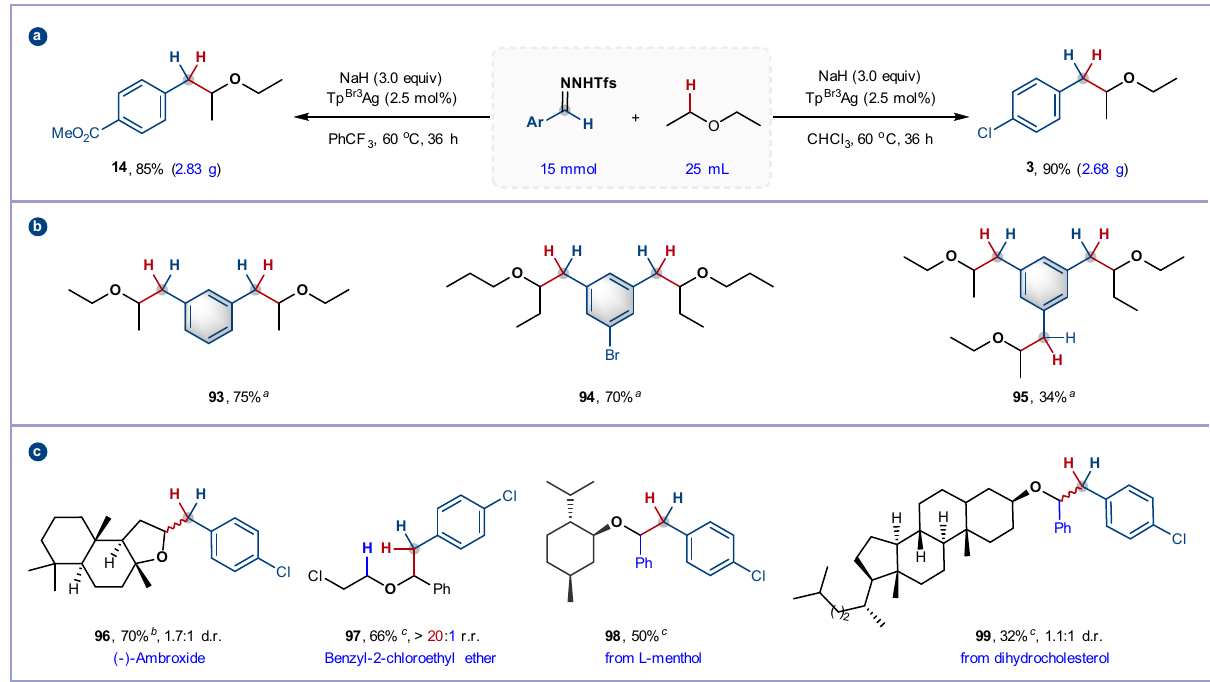
Fig. 6 Gram-scale synthesis and synthetic applications. a Gram-scale reactions. b Application as cross-linker for C(sp 3 ) – H bonds. c Late-stage C – H benzylation of complex molecules. Isolated yield. a Ether (5.0 mL) was used. b Ether (5.0 equiv.) was used. c Ether (2.0 equiv.) was used. r.r., regioisomeric ratio. d.r., diastereomeric